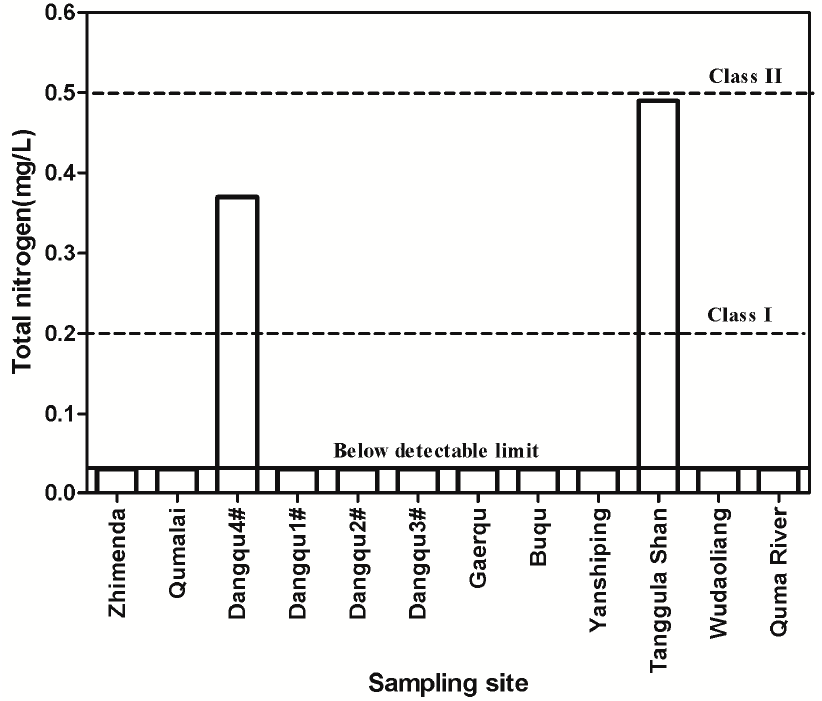
Figure 2. The concentration of total nitrogen in river water of each sampling site in the SRYR.